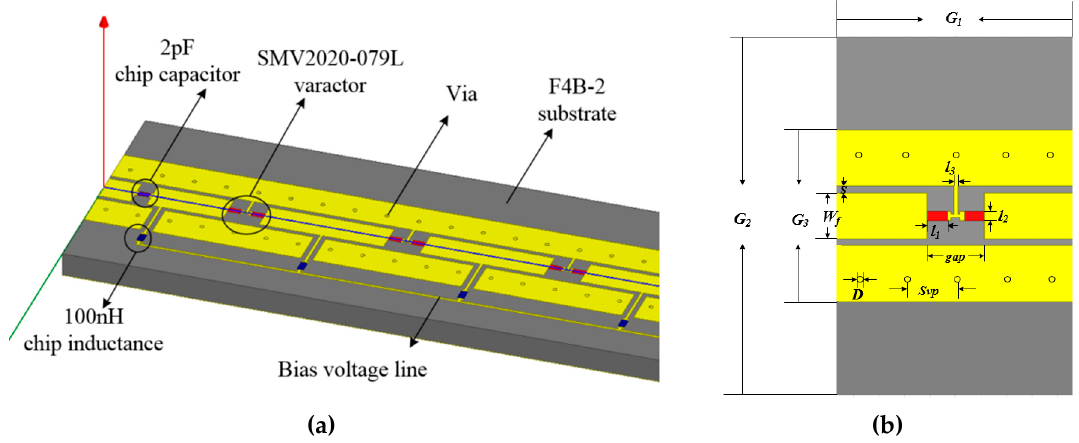
Figure 1. Scheme of the proposed leaky-wave antenna (LWA). ( a ) Structure of the LWA; ( b ) Top view of the unit cell.